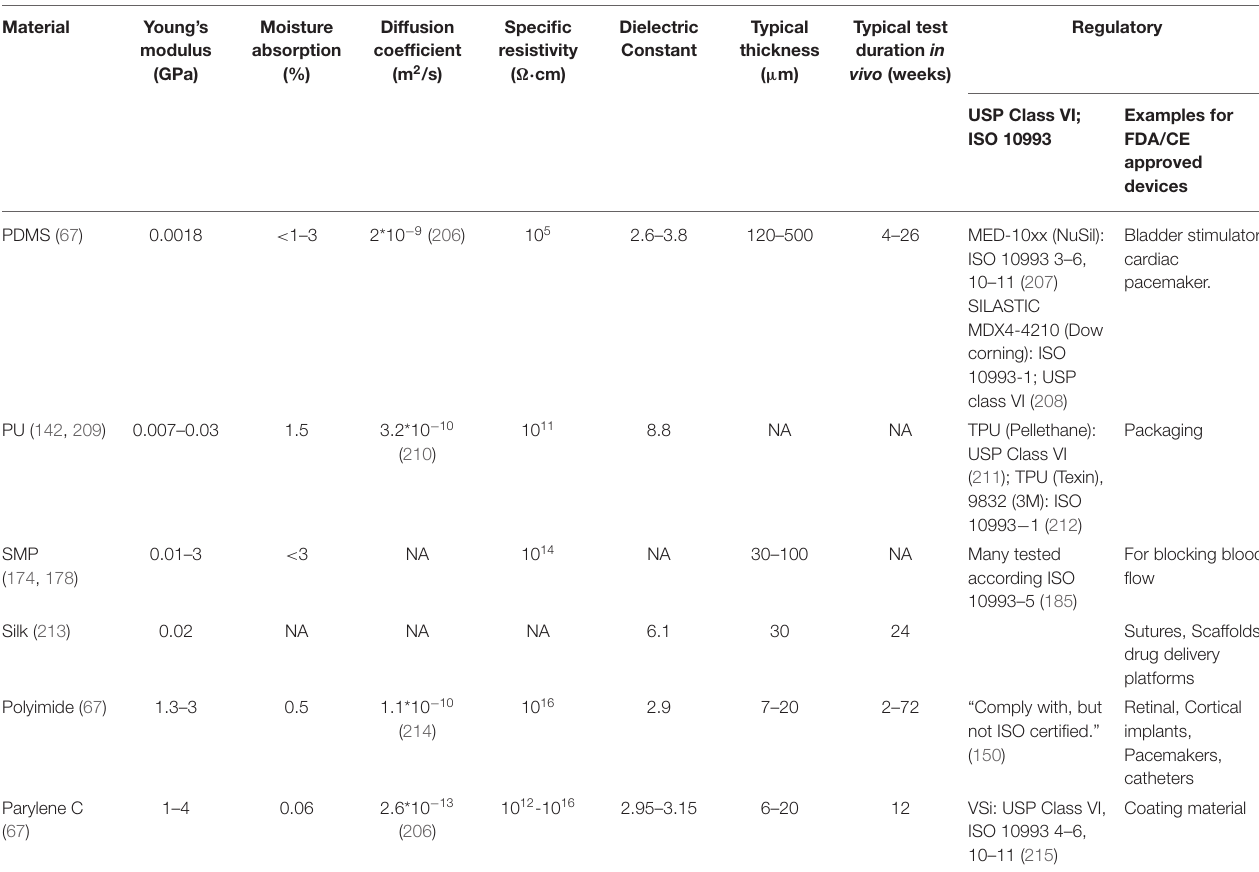
TABLE 1 | A comparison between different flexible materials used as electrode array substrates.